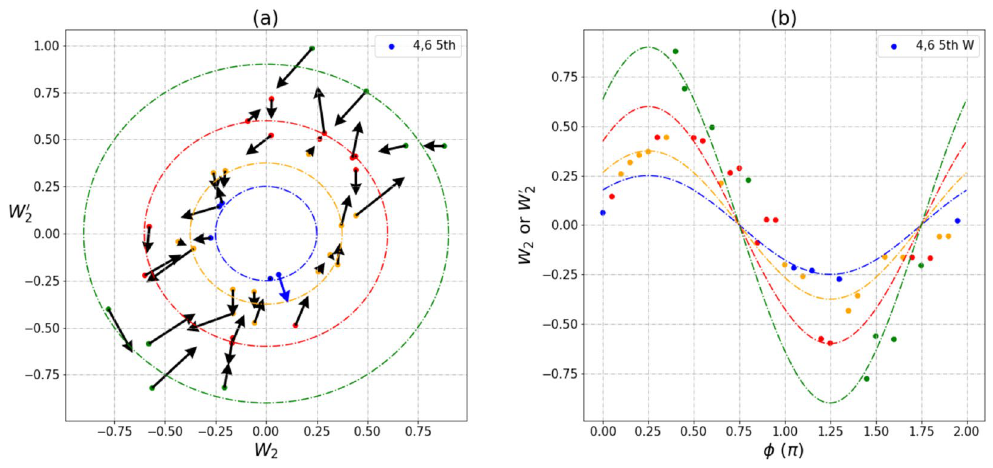
W ′ W 2 and measurement of pair [4,6]. ( a ) The 2 (cid:30) (cid:31) W ′ W 2 (cid:31) (cid:30) , and phase angles φ. Data measured on 2 (cid:30) (cid:31) (cid:31) (cid:30)